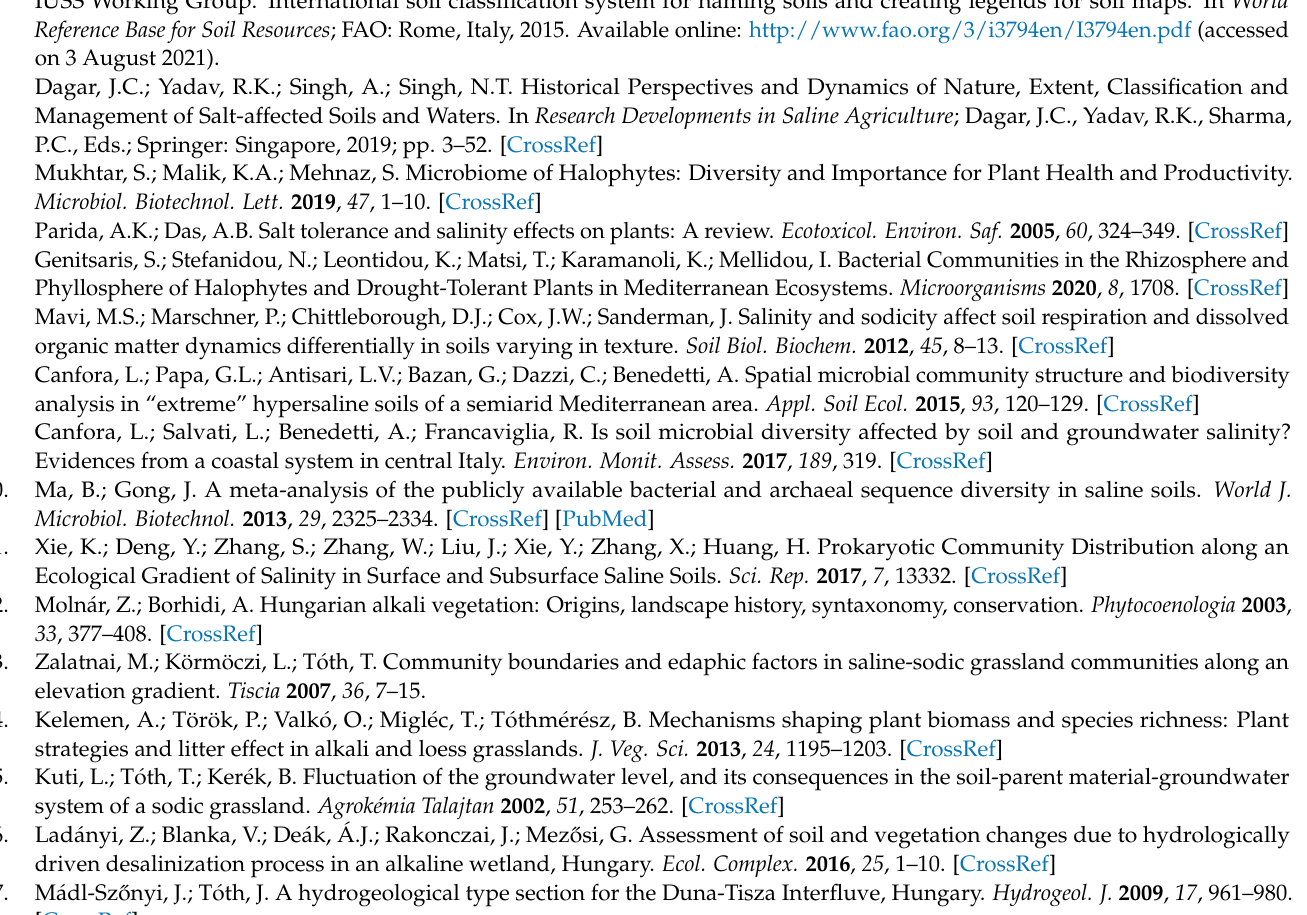
ANOVA results of the soil basal respiration (Figure S1), Table S3: ANOVA results of the cumulative substrate induced respirations (Figure S2), Table S4: PERMANOVA results based on Bray–Curtis dissimilarities using abundance data for MicroResp (Figure S3), File S1: Data S1: Soil chemical data, Data S2: microResp